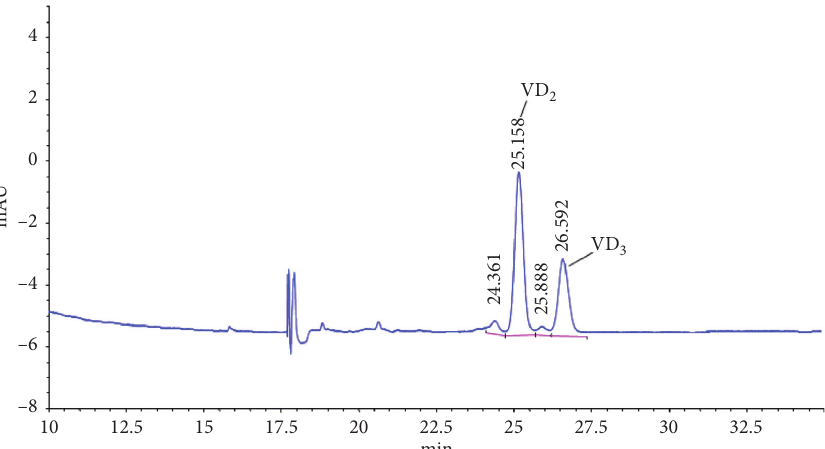
2 and D 3 in Lentinus edodes (spiking levels 100 μ g/100g for VD 2 and